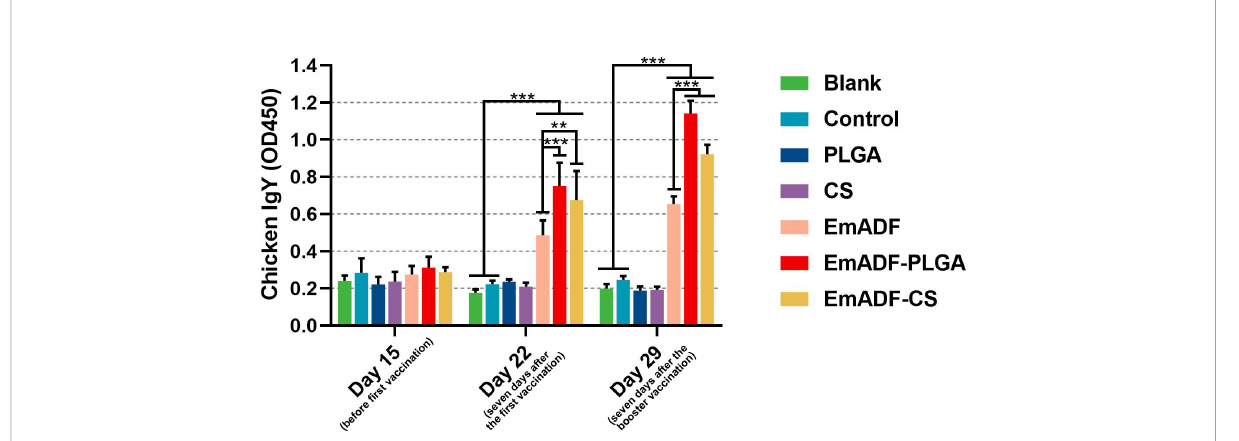
FIGURE 5 Determination of EmADF-speci fi c antibody in the chickens ’ sera. Each group involved fi ve biological replicates, and each replication was detected once. Values were estimated using one-way ANOVA analysis followed by Dunnett ’ s test. Comparisons among EmADF, EmADF-PLGA, and EmADF-CS group were conducted by ANOVA following Bonferroni ’ s correction. Values were presented as the mean of the mean ± SD. ** p< 0.01 and *** p< 0.001.